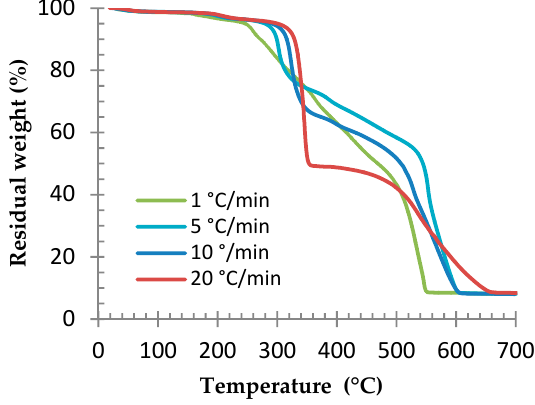
Figure 8. TGA of compressed microspheres at various temperature ramps, under air.